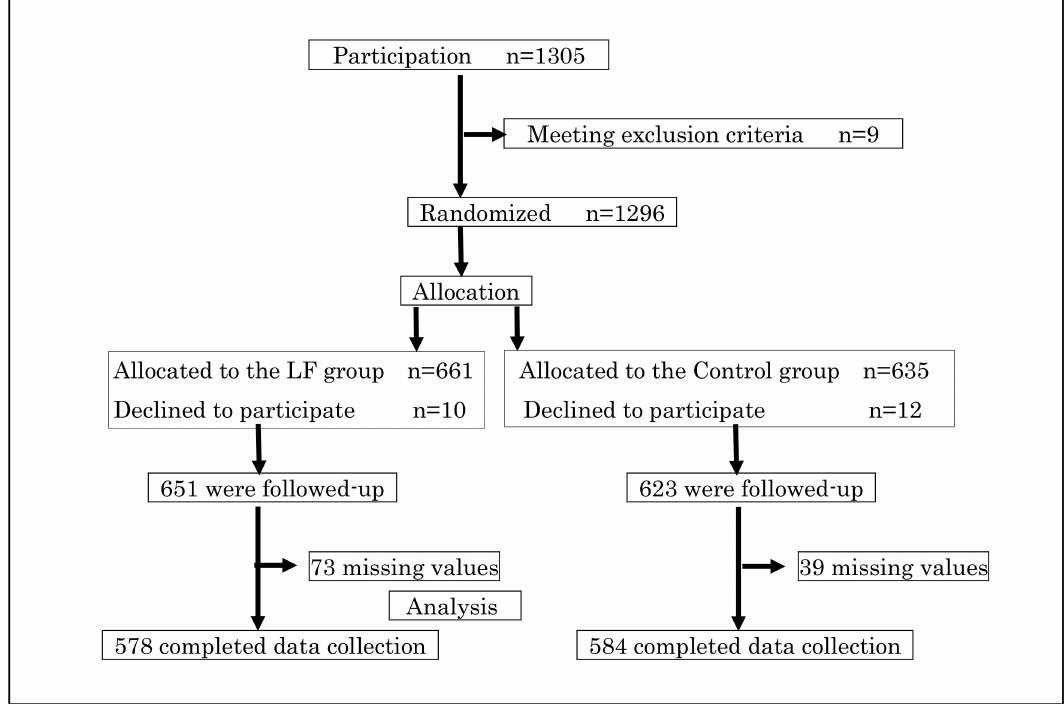
Figure 1. This figure is the study profile. Children wishing to participate were 1305, and 9 children were excluded, and 1296 children were randomized into the LF group or the control group. Finally, 578 LF of the group and 584 of the control group were statistically